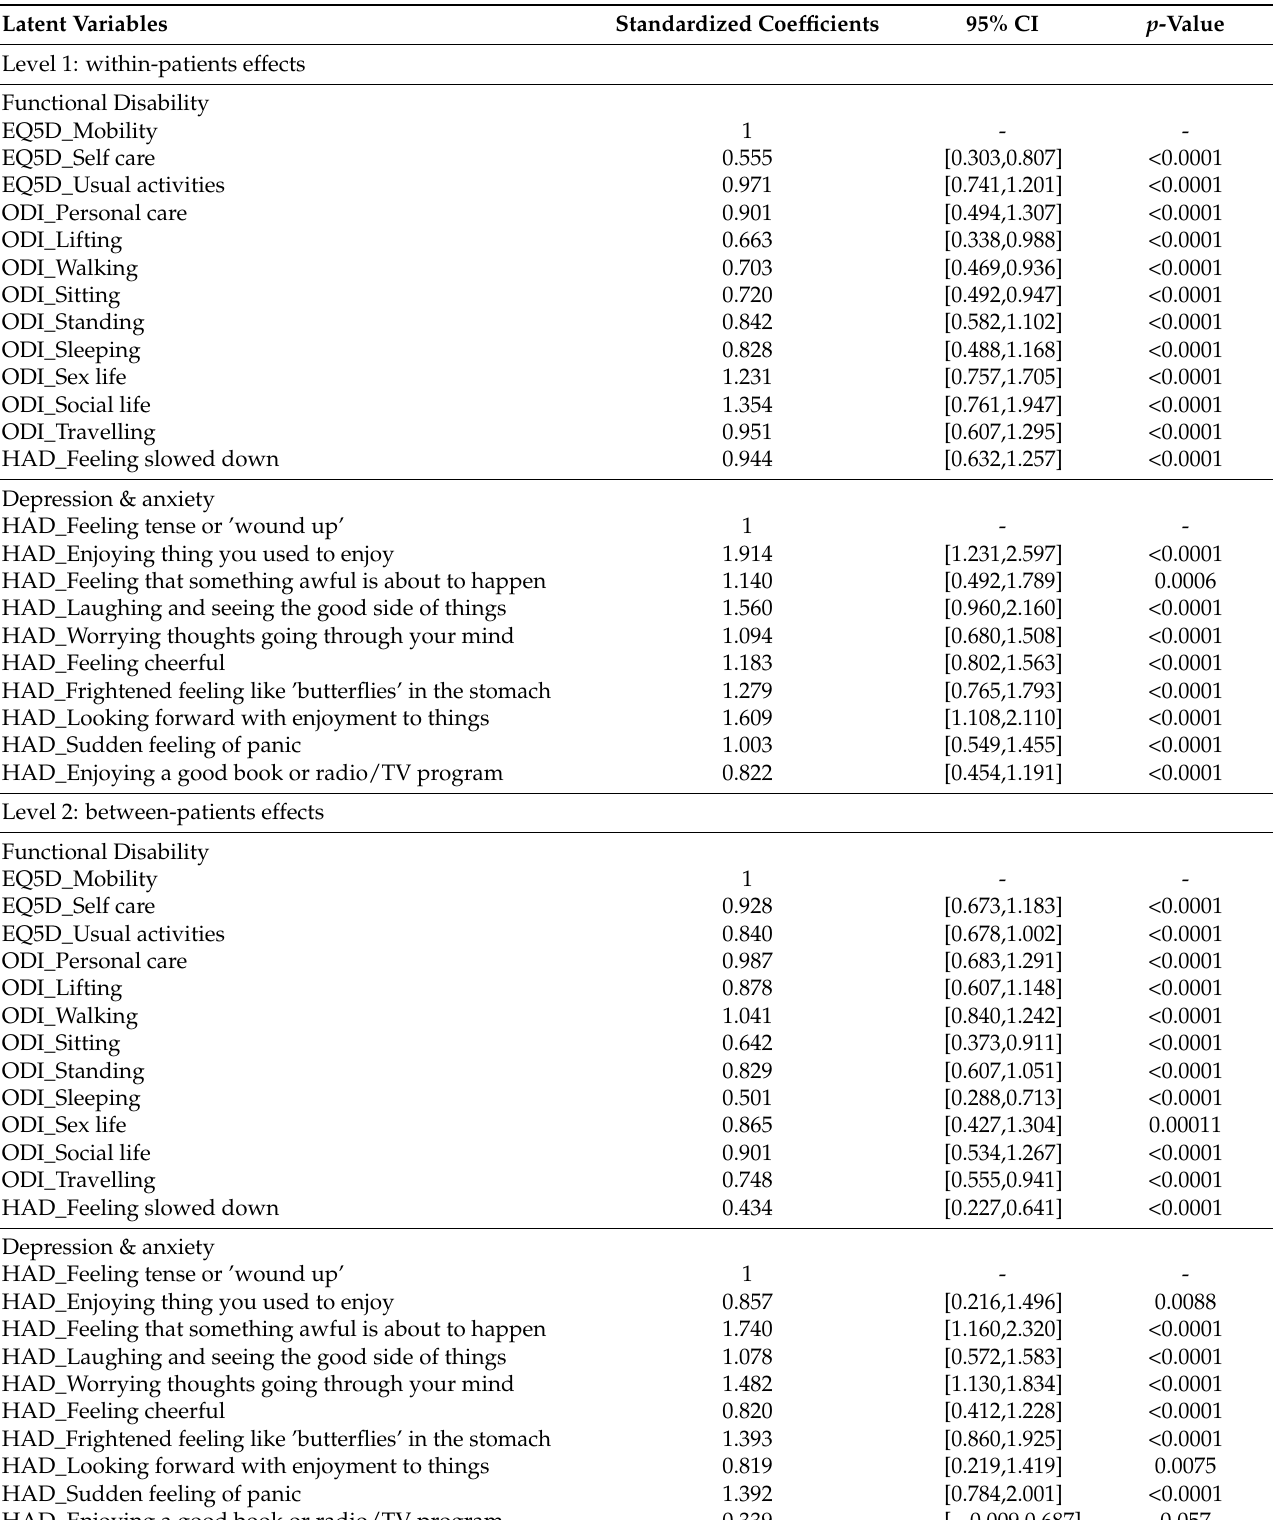
Table 2. Multilevel CFA model results: Standardized coefficients, their 95% CIs and their significance p